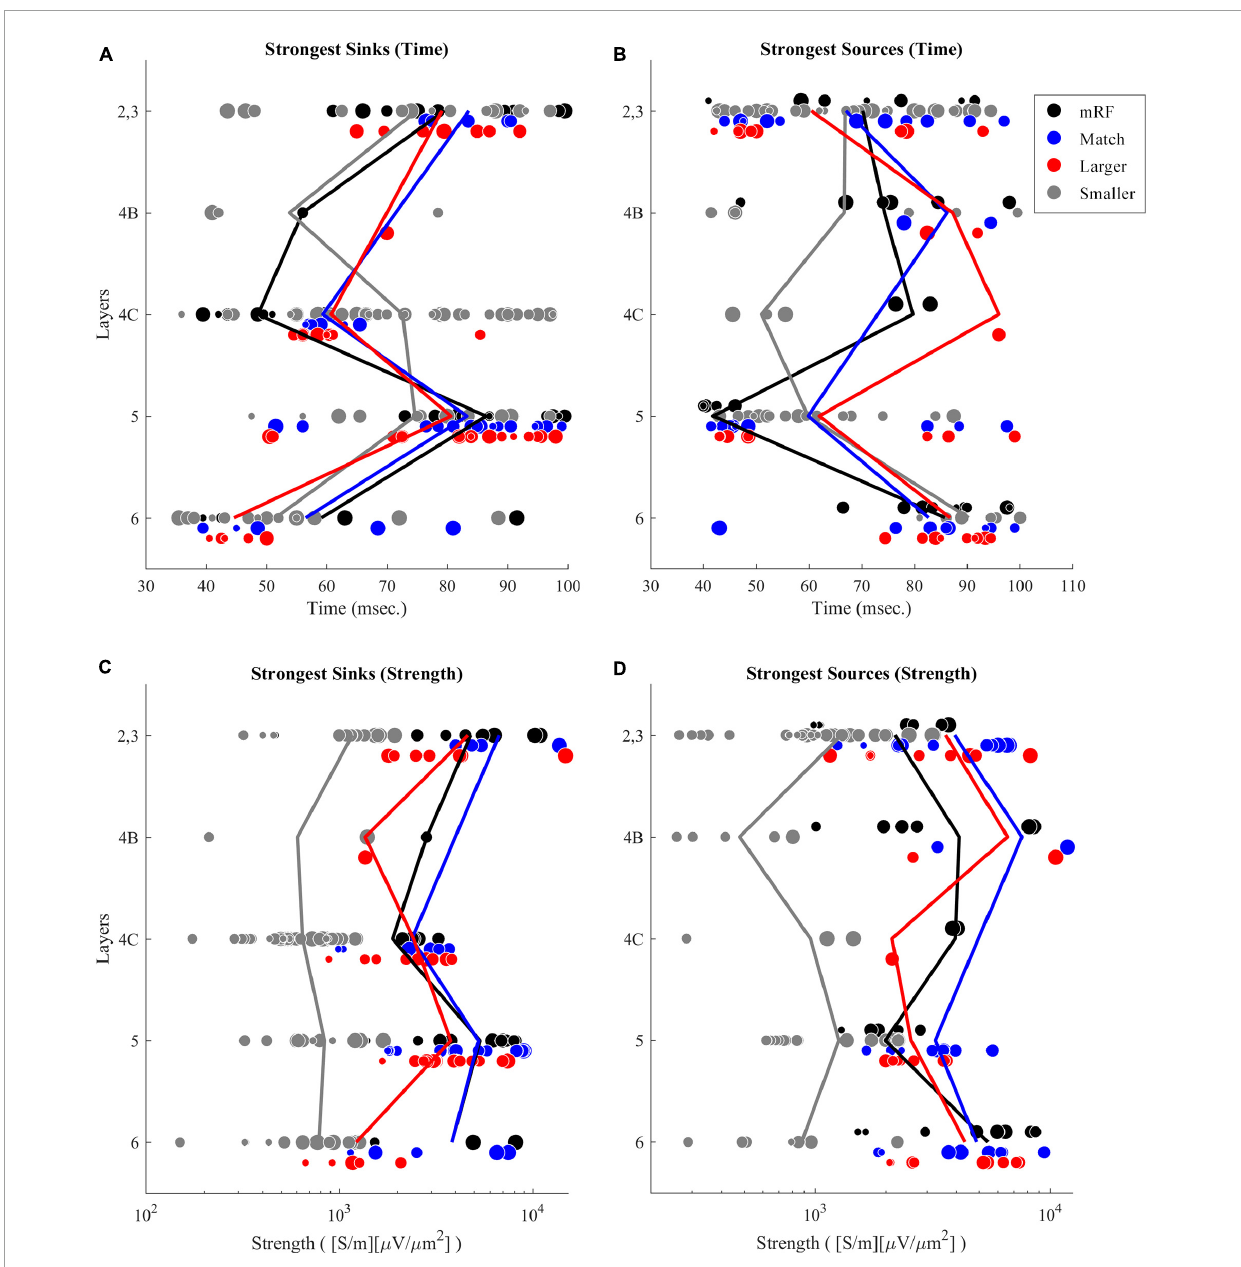
FIGURE5 Time of strongest sinks (A) and sources (B) by differentiating the layers. Black dots refer to 0.5 ◦ black square stimulus. Blue, red, and gray ones refer to stimuli of equal size with receptive field (RF), larger, and smaller than RF, respectively. The solid lines also show the mean value of times for each stimulus. The strength of the strongest sinks (C) and sources (D) by differentiating the layers are also presented. The solid lines also show the mean value of strength for each stimulus. In the panels (A,B) , the horizontal axis shows the time. In the panels (C,D) , the horizontal axis shows the strength of current sinks and sources (CSD). The vertical axis in all figures defines the layers. The chart guide differentiates each stimulus based on the specified color. The size of the marked points on the graph increases with increasing